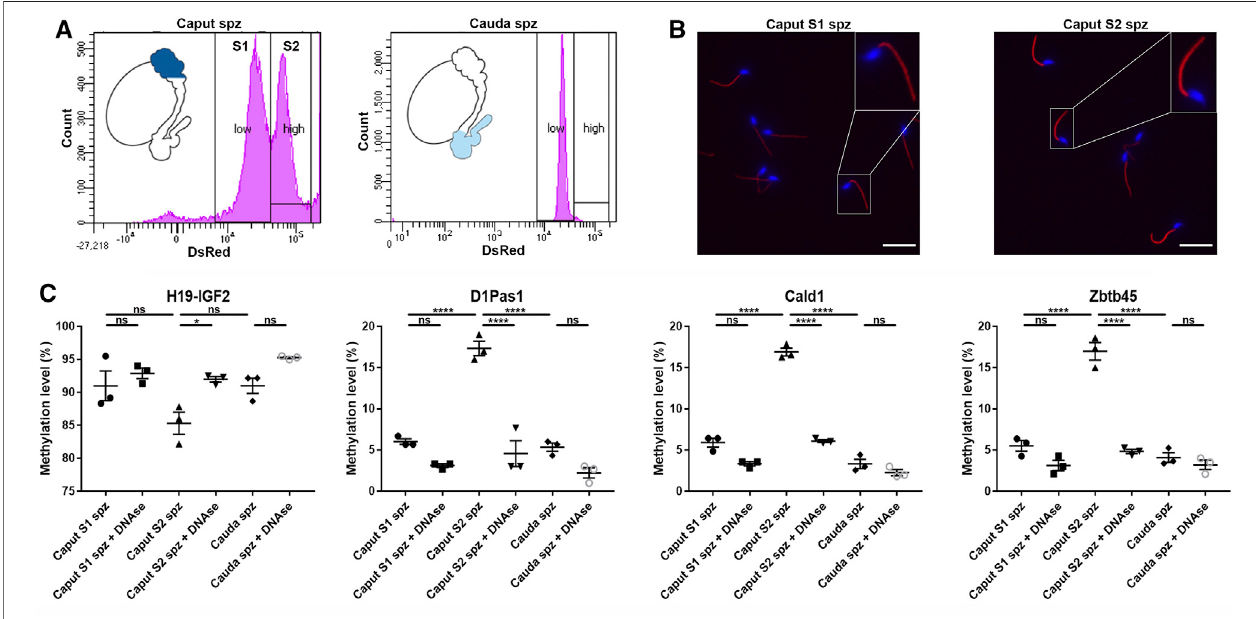
FIGURE 10 | Methylation pro fi les of D1Pas1, Cald1 and Zbtb45 in caput epididymal sperm with low and high DsRed intensity levels. (A) Sperm subpopulations wereanalyzedbyFACSaccordingtotheirendogenousDsRedintensitylevels(S1:subpopulationwithlowDsRedintensity,S2:subpopulationwithhighDsRedintensity) and (B) observed under a fl uorescent microscope. Insets (yellow squares) represent ×2 magni fi cations of spermatic heads. Scale bar: 20 μ m (C) Prior to sperm DNA extractionandpyrosequencingonH19-IGF2,D1Pas1,Cald1andZbtb45loci,spermsubpopulationsweretreatedornotwithDNaseI(+DNAse).H19-IGF2served to assess the presence of somatic cell contamination. Spz: spermatozoa; *, **, and **** indicate p -values of p < 0.05, < 0.005, and < 0.0001 respectively.